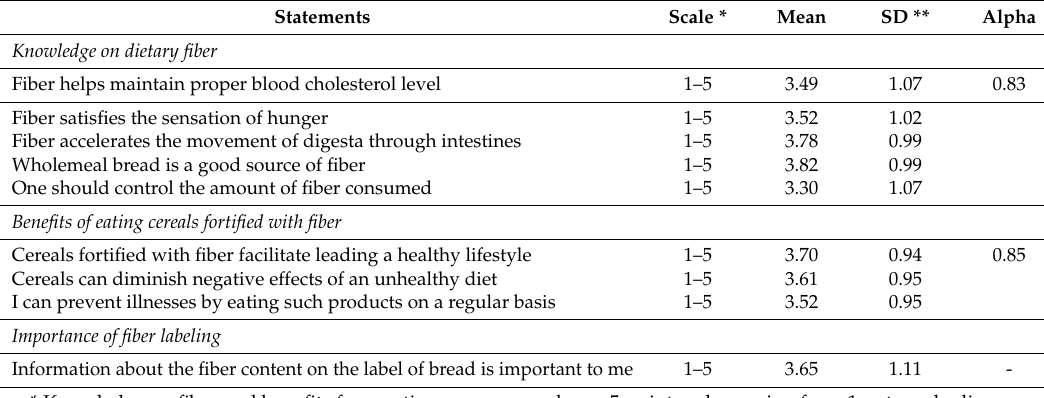
Table 1. Respondents’ opinions on dietary